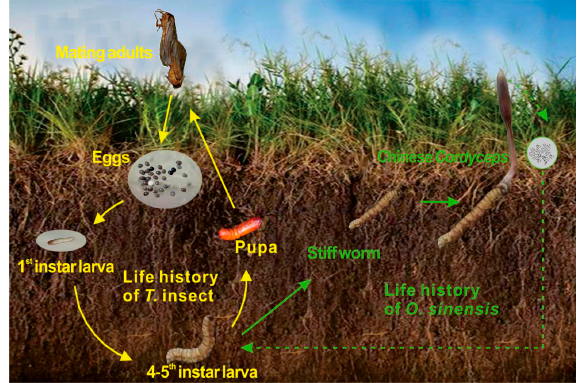
Figure 1. Life history of Ophiocordyceps sinensis and Thitarodes host [5].